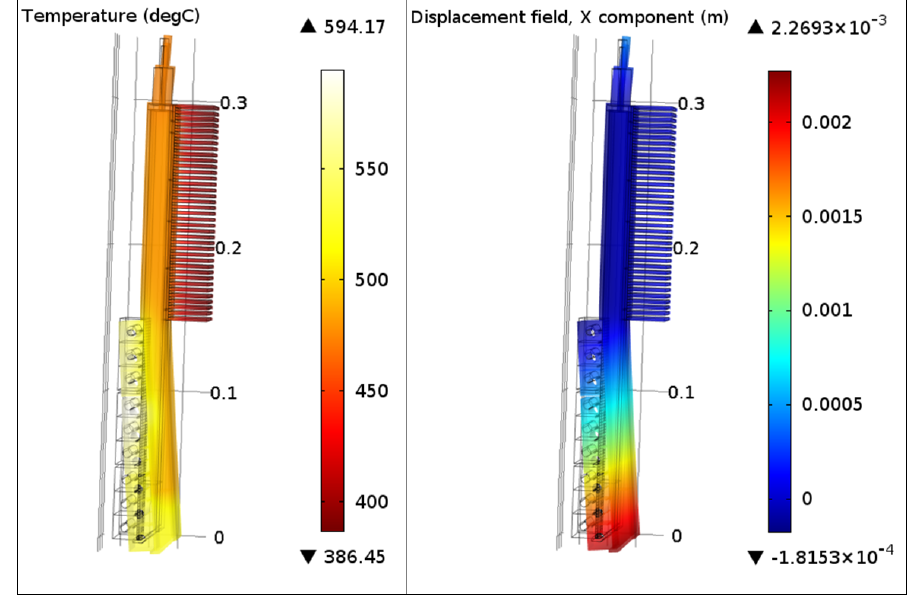
Figure 7. Temperature distribution [ º C] and corresponding thermal deformation [m] of the heat pipe.